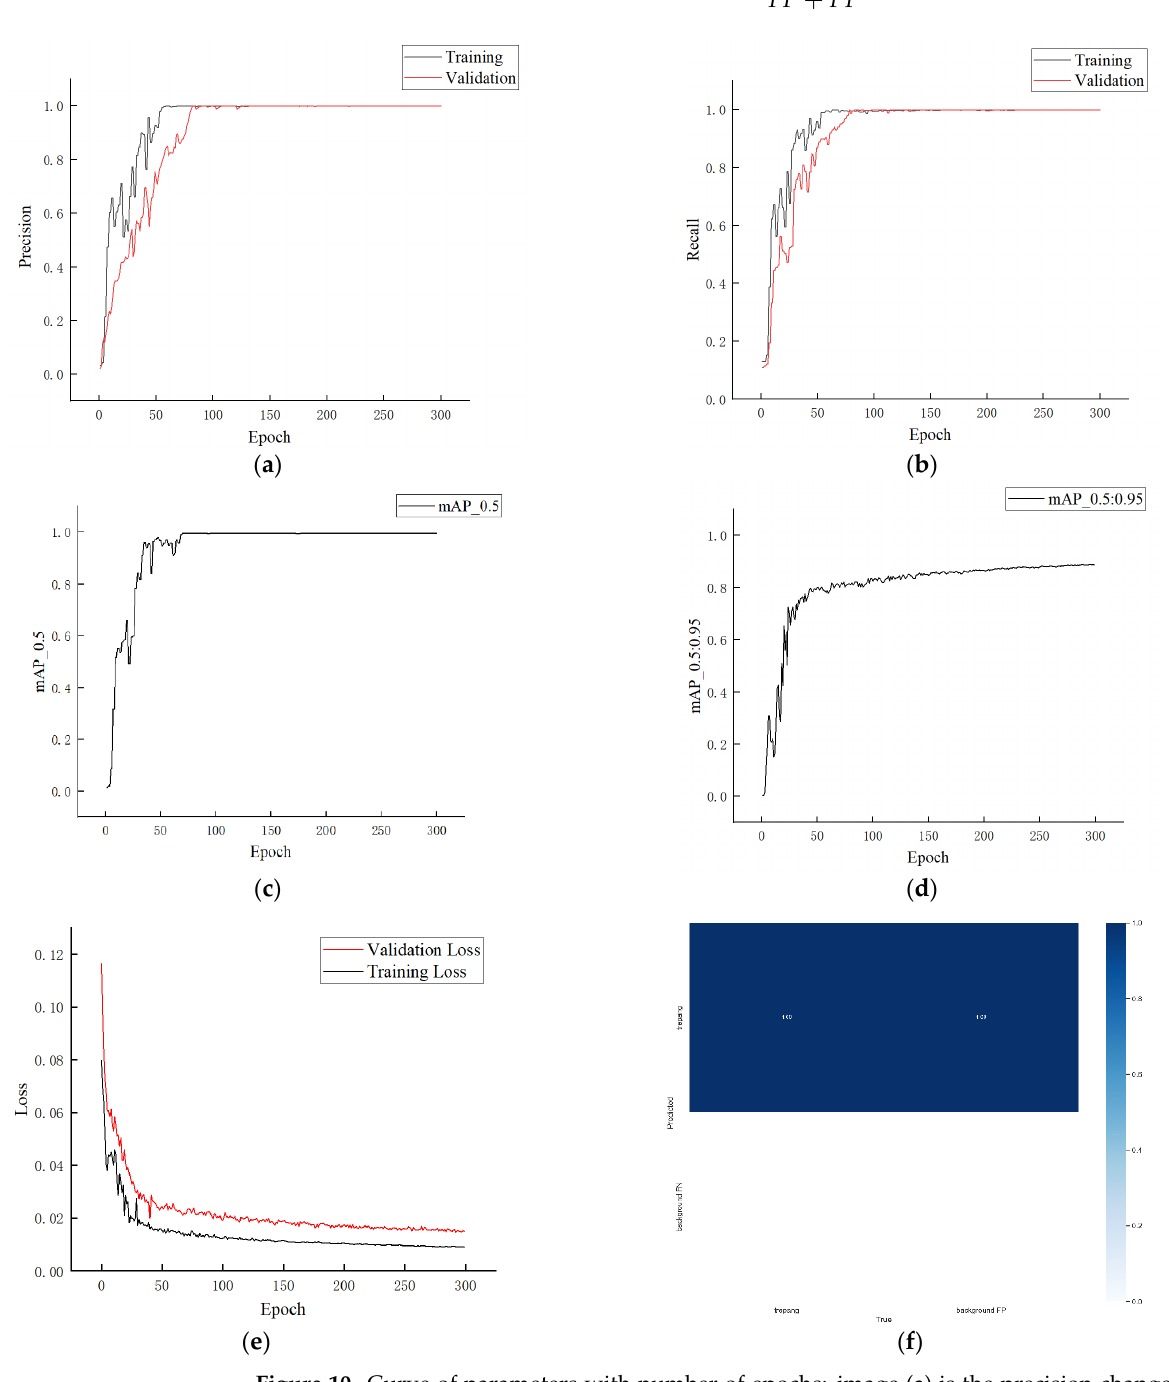
Figure 10. Curve of parameters with number of epochs: image ( a ) is the precision change curve; image ( b ) is the recall change curve; image ( c ) and image ( d ) are mAP curves; image ( e ) is the loss value change curve; and image ( f ) is the Confusion matrix.